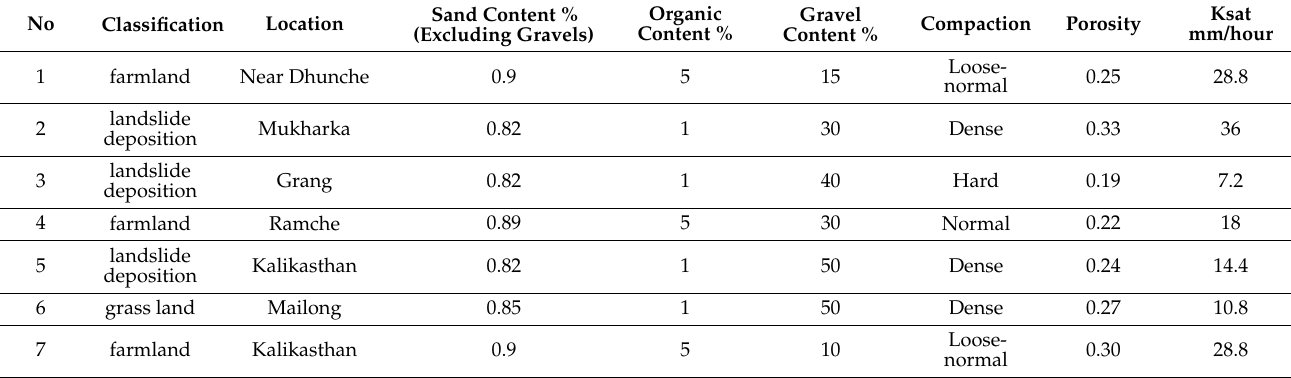
Table A1. Table of Soil Test